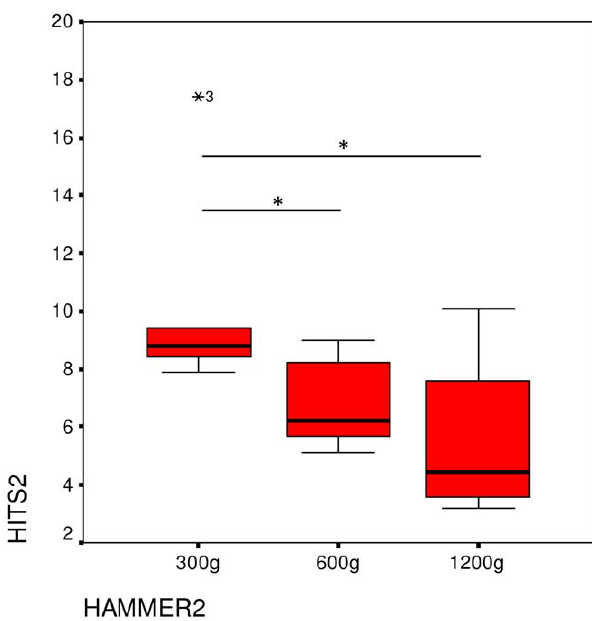
Figure 6. Median time needed to crack open a nut as a function of hammer weight in Experiment 2